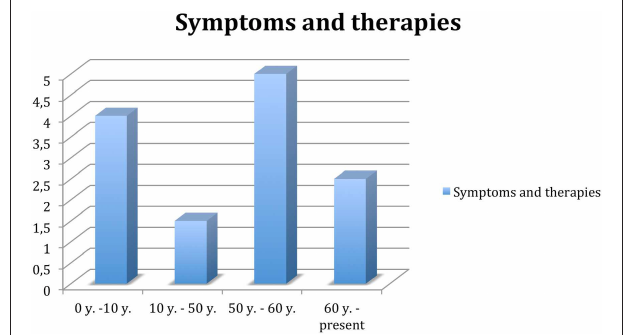
FIGURE 1 | Trend of symptoms and related therapy throughout the patient’s life. 0–10 years, remarkable presence of symptoms, no therapy. Ten to fifty years, attenuation of the frequency of symptoms, especially in stress-related contexts; classified as focal epilepsy; treated with levetiracetam, clonazepam, and valproate. Fifty to sixty years, significant increase in the frequency of symptoms, as well as depression and socio-relational difficulties; treated with anti-epileptics, hypnoinductors, anxiolytics, and antidepressants. Sixty-present, excluding diagnosis of epilepsy, gradual anti-epileptic suspension; remained on